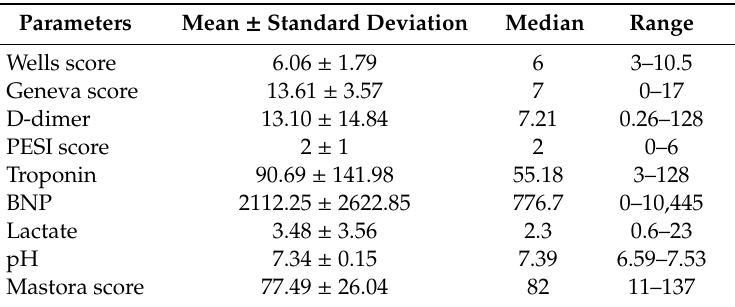
Table 1. Analysis of clinical and radiological parameters.